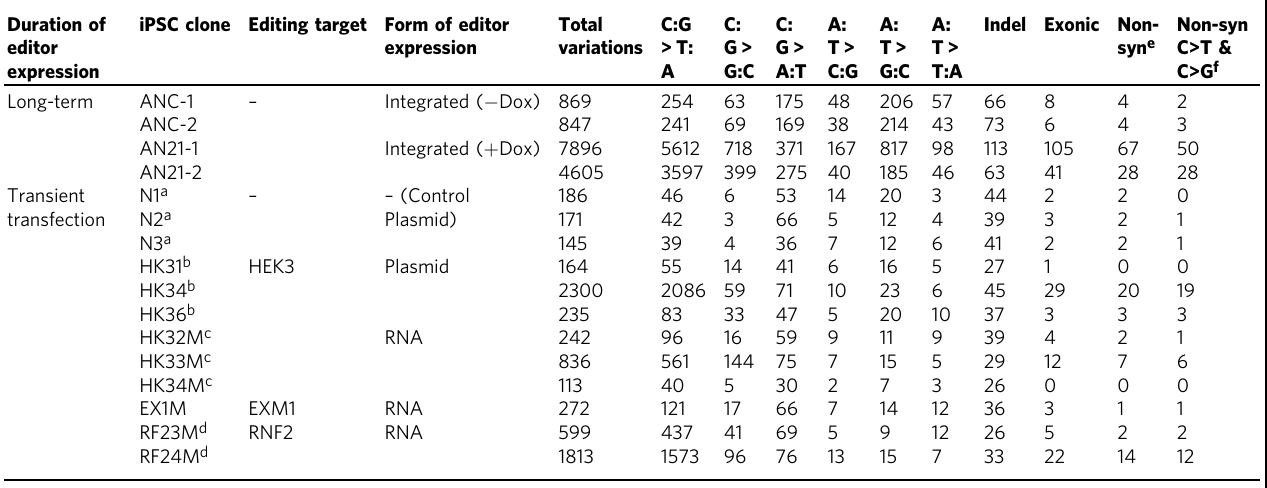
Fig. 1 WGS analysis of iPSC clones after long-term cytidine base editor expression reveals increased mutations. a Schematic of the doxycycline-inducible XL-AncBE4max piggyBAC construct inserted into the CL1 line. b Diagrammatic representation of experimental design for clonal expansion and whole- genome sequencing analysis of iPSCs with or without doxycycline-induced 21-day base editor expression. c Mutation numbers in uninduced (ANC-1 and ANC-2) and induced (AN21-1 and AN21-2) iPSC clones. The numbers are total sequence variations, including indels and single nucleotide variations, as compared to the sequence of the parental CL1 iPSCs. d Fractions of each type of mutations in uninduced and induced clones. Source data for c and d are provided in the Source Data fi le. Table 1 Summary of whole-genome sequencing of iPSC